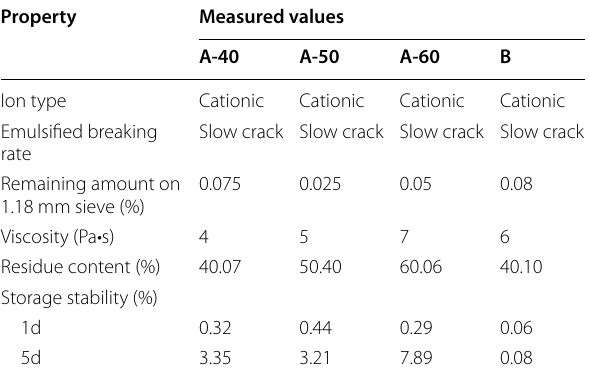
Table 2 Basic performances of the studied emulsified asphalt binders